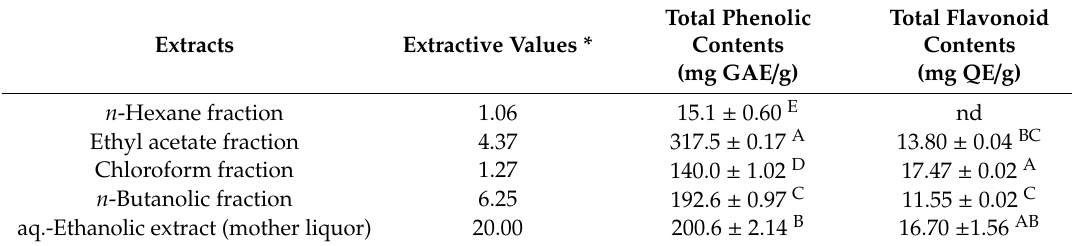
Table 2. Total phenolics, total flavonoids of the extracts of Suaeda